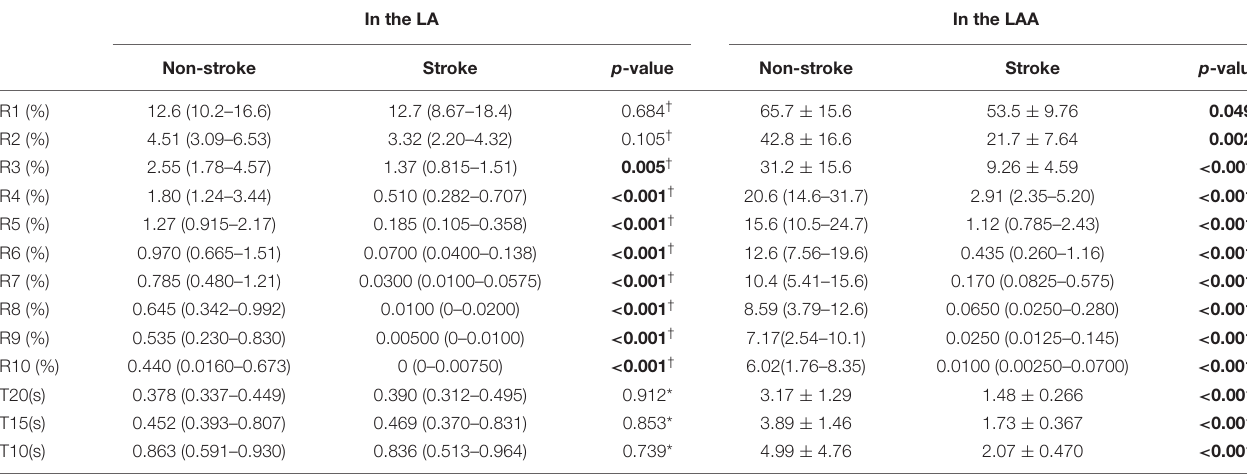
Values are presented as mean ± SD or median (IQR); p-values display significance between the non-stroke group and stroke group. *Independent samples t-test. † Mann- Whitney U-test. R1, R2, ... , R10 means the residual ratios of initial blood at the end of 1st, 2nd, ... , 10th cardiac cycle; T20, T15, T10 means the time when the residual ratios of initial blood reduced to 20, 15 and, 10%. The bold values mean “significant differences”.